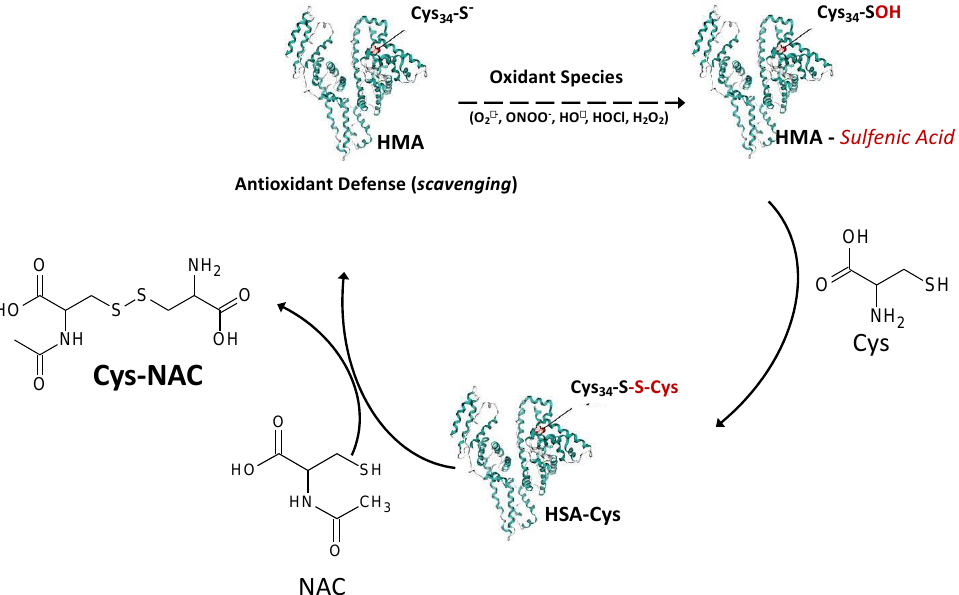
Figure 10. Indirect antioxidant mechanism of NAC at extracellular level - Cys34 of mercaptoalbumin (HSA-SH) efficiently scavenges oxidant species forming the corresponding sulfenic acid which then reacts with Cys to form the cysteinylated adduct (HSA-Cys). NAC is able to selectively break the disulfide bond of HSA-Cys leading the disulfide NAC-Cys and the free form of Cys34 which in turn further acts as antioxidant.